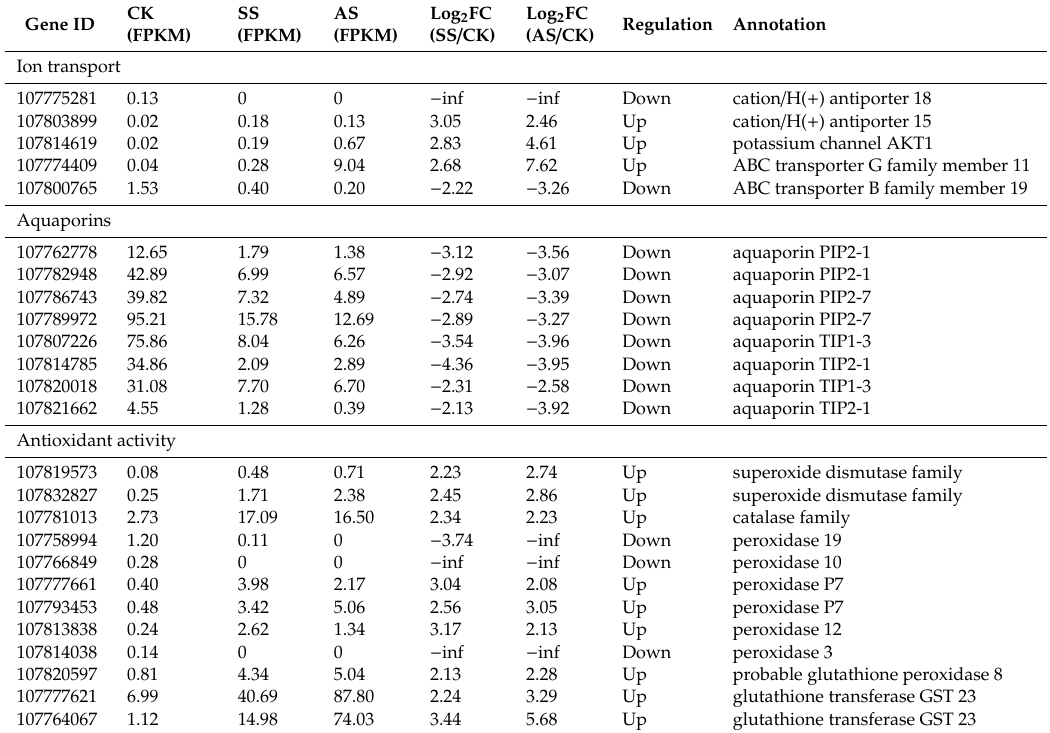
Table 4. Candidate DEGs under SS and AS